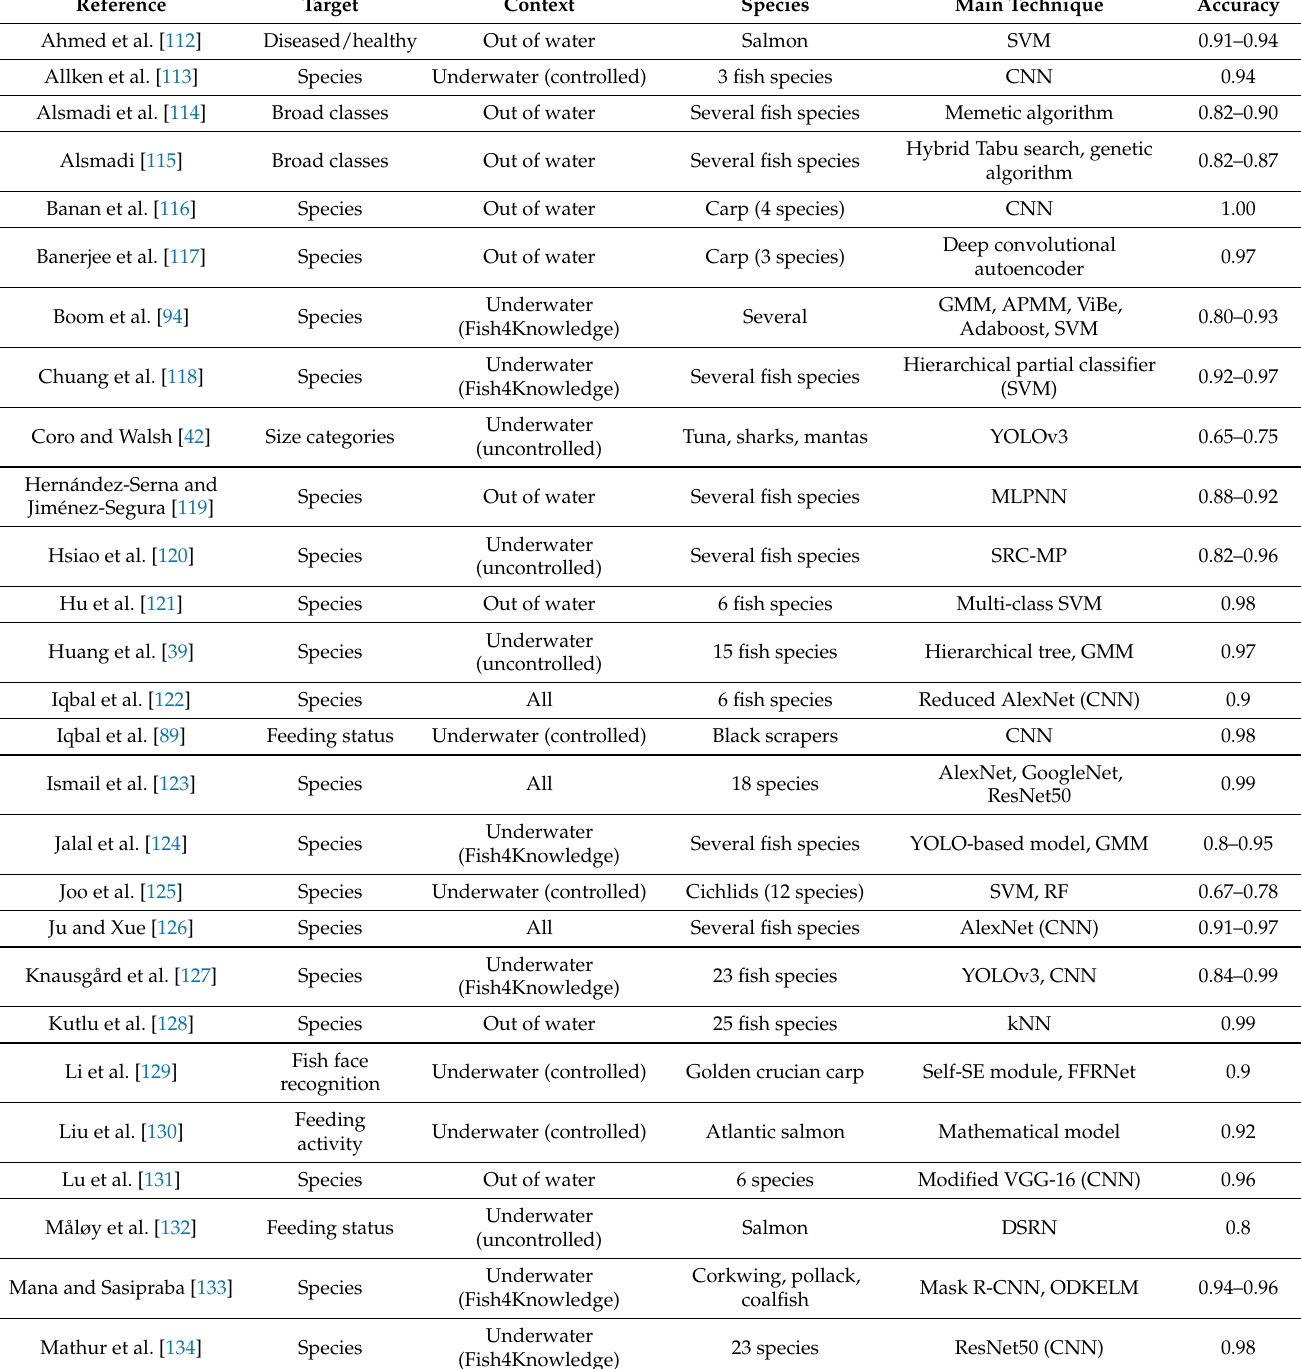
Table 6. List of articles dealing with the classification of